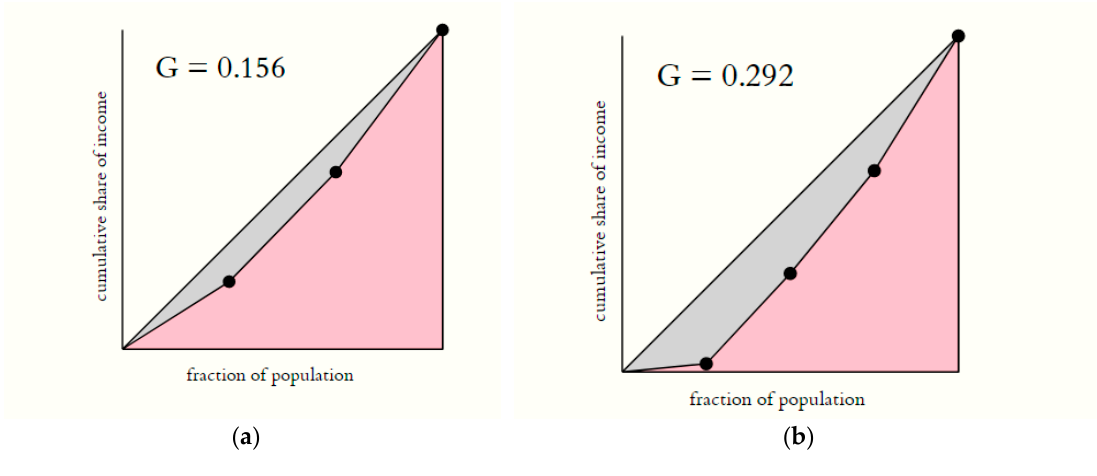
Figure 4. Shape of the Lorenze curve (Source: Shlegeris n.d.).